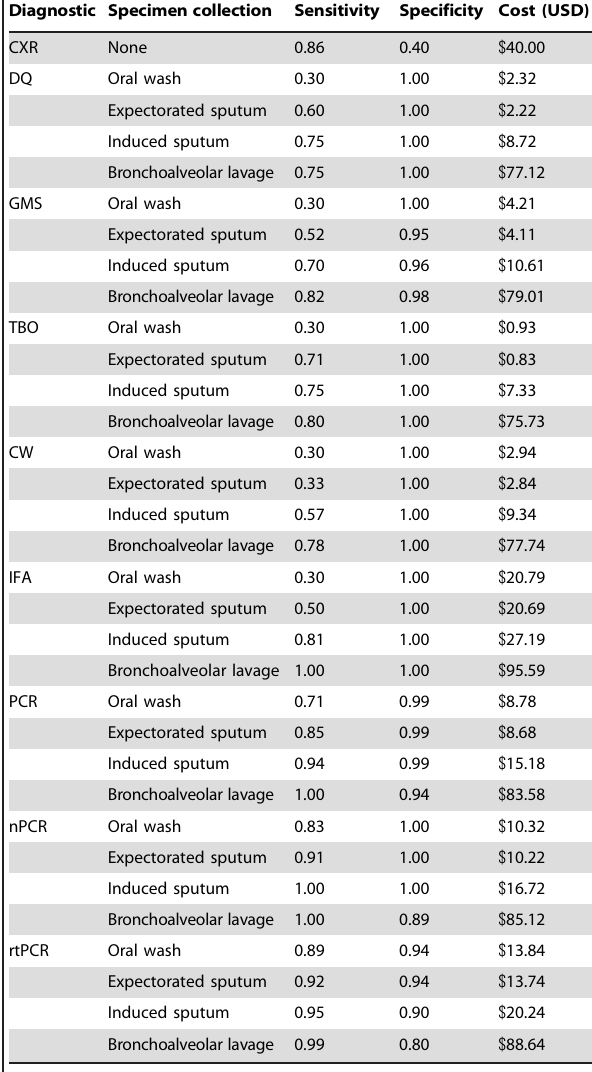
Table 1. Model inputs and costs: Sensitivity and specificity of diagnostic procedures, based on estimates derived from existing studies (see text) or, when reference studies not available, from author